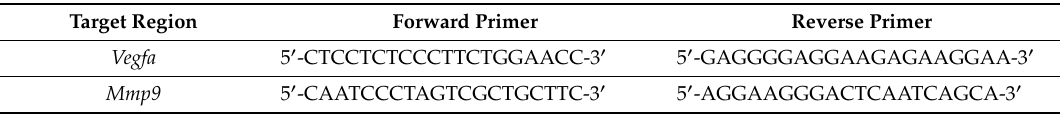
Table 2. Primers used for DNA methylation